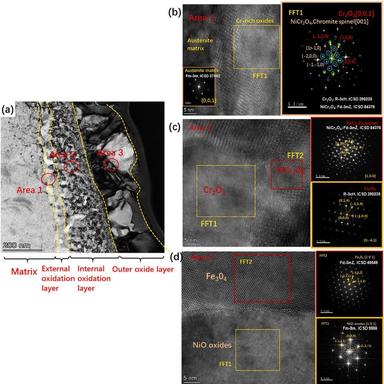
(a) cross-sectional TEM image of the thicker oxide scale (Region C in) formed in SCW at 600 ◦C for 24 h, (b) high-resolution TEM imaging and FFT analysis of Area 1 in (a)-matrix and external oxidation layer, (c) high-resolution TEM imaging and FFT analysis of Area 2 in (a)- internal oxidation layer, (d) highresolution TEM imaging and FFT analysis of Area 3 in (a)- outer oxide layer.